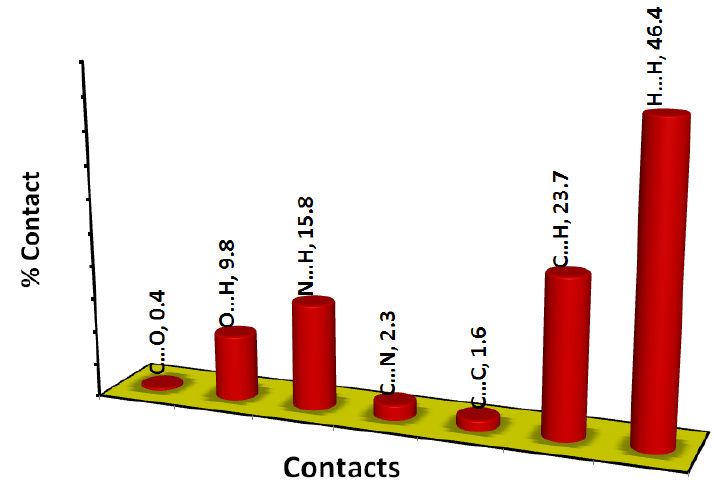
Figure 6. Intermolecular interactions and their percentages in 4 .